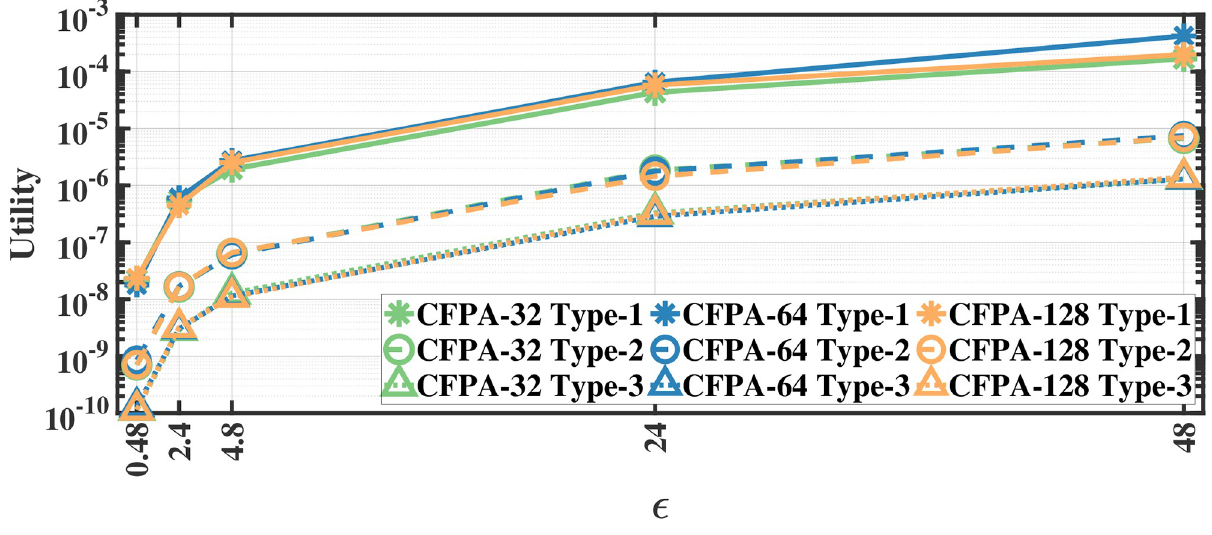
Fig 8. Utility of the CFPA for